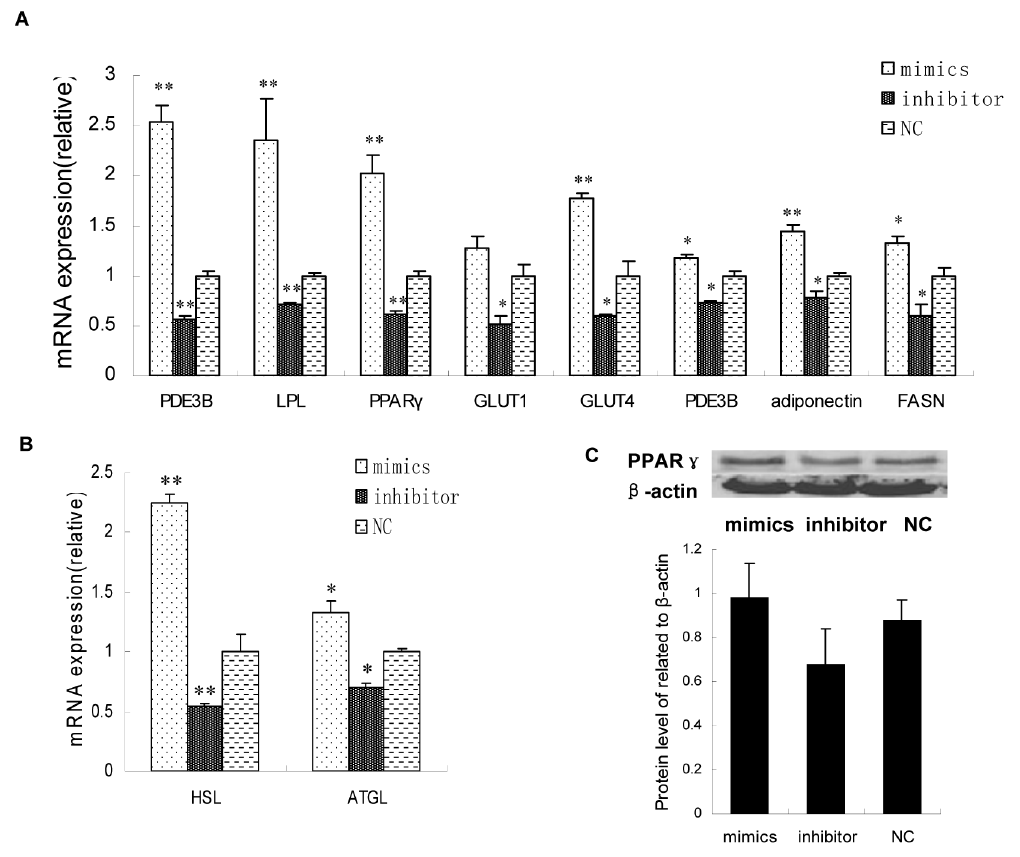
Figure 6. Fat metabolism related gene expression after transfection with miR-181a mimic and inhibitor. (A) Expression levels of PDE3B , LPL , PPARγ , GLUT1 , GLUT4 , adiponectin and FASN genes measured by qRT-PCR dramatically increased in cells after transfection of the miR-181a mimic vs. control, while they obviously decreased after transfection of inhibitor vs. control. Interestingly, (B) mRNA levels of HSL and ATGL increased after transfection with miR-181a and decreased after transfection with the inhibitor (* P < 0.05, ** P < 0.01, n = 6). (C) Western blotting showed that the miR-181a may have increased protein levels of PPARγ. doi: